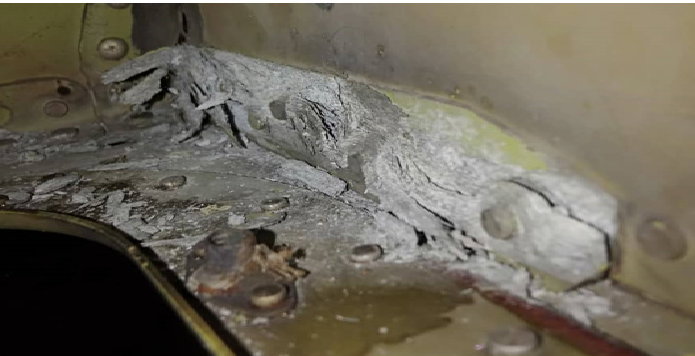
Figure 6. Corrosion on Wing Spar.